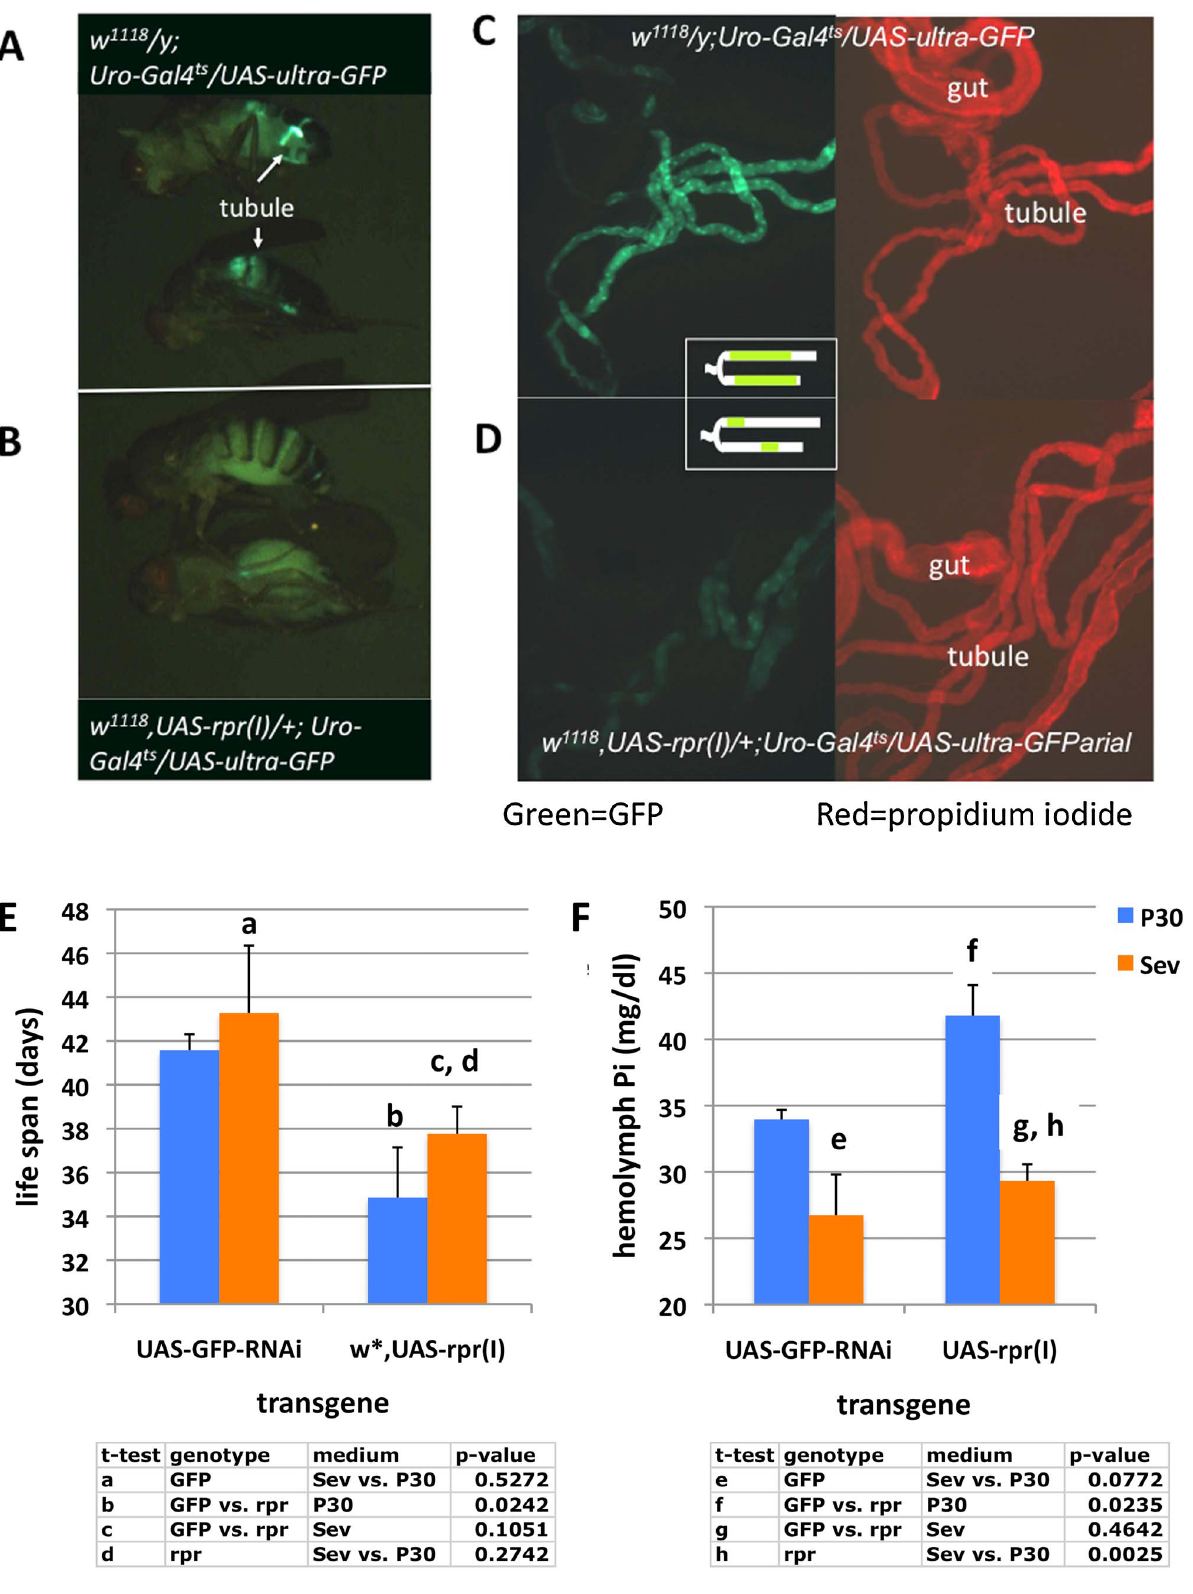
Figure 4. Principal cell ablation increases hemolymph phosphate and decreases life span, rescue by addition of sevelamer to the culture medium. A, B: Micrographs of 10 days old males with expression of GFP (green) in principal cells ( A ) or females with expression of GFP along with reaper ( rpr ) in principal cells after culture for ten days at 29 u C ( B ). Epifluorescent microphotograph (10X) of tubule and gut of the same